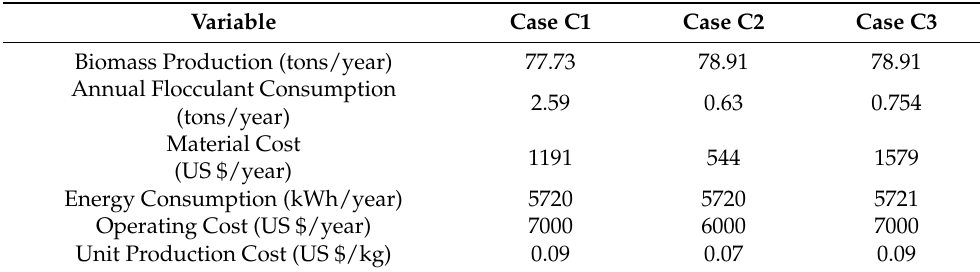
Table 3. Summary of Results for Primary Harvest